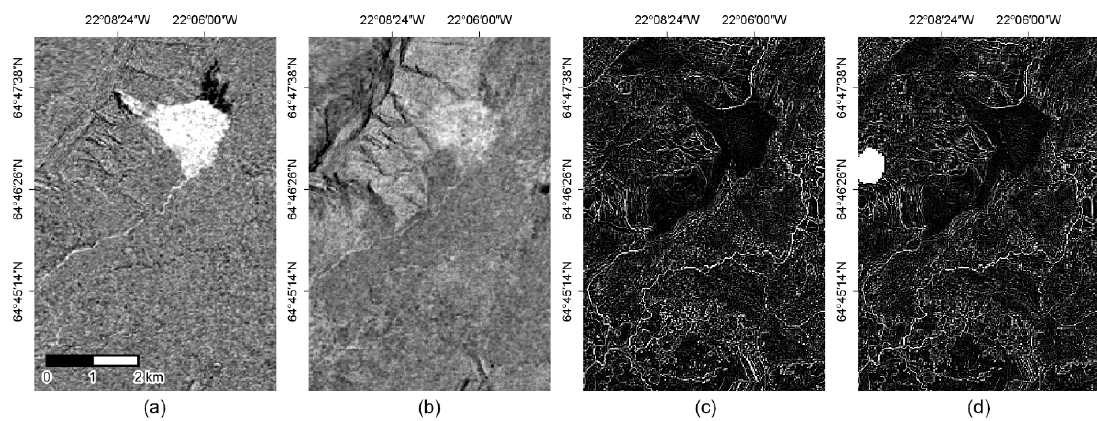
Figure 4. Examples of the layers extracted from the Sentinel-1 and Sentinel-2 datasets. ( a ) and ( b ) show the subtraction layers using pre- and post-event Sentinel-1 VV polarization intensity images for 2018 and 2019, respectively. The Hítardalur landslide and the landslide-dammed lake are distinguishable. ( c ) and ( d ) show the edge extraction layers derived from the post-event Sentinel-2 images (Near-infrared (NIR) band (B8)) for 2018 and 2019, respectively.